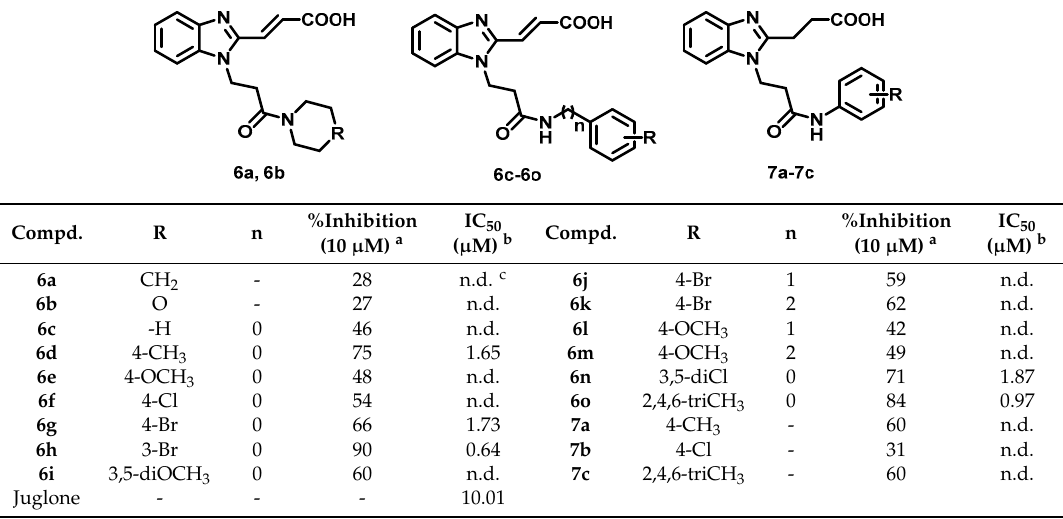
Table 1. The structure and inhibitory activity against Pin1 of 6a–6o and 7a–7c .